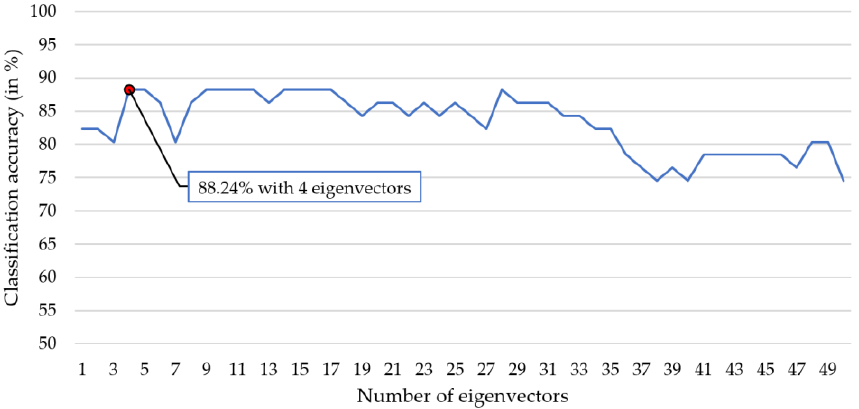
Figure 6. The plot of classification accuracy against the number of chosen eigenvectors in KERP feature using LDA classifier.